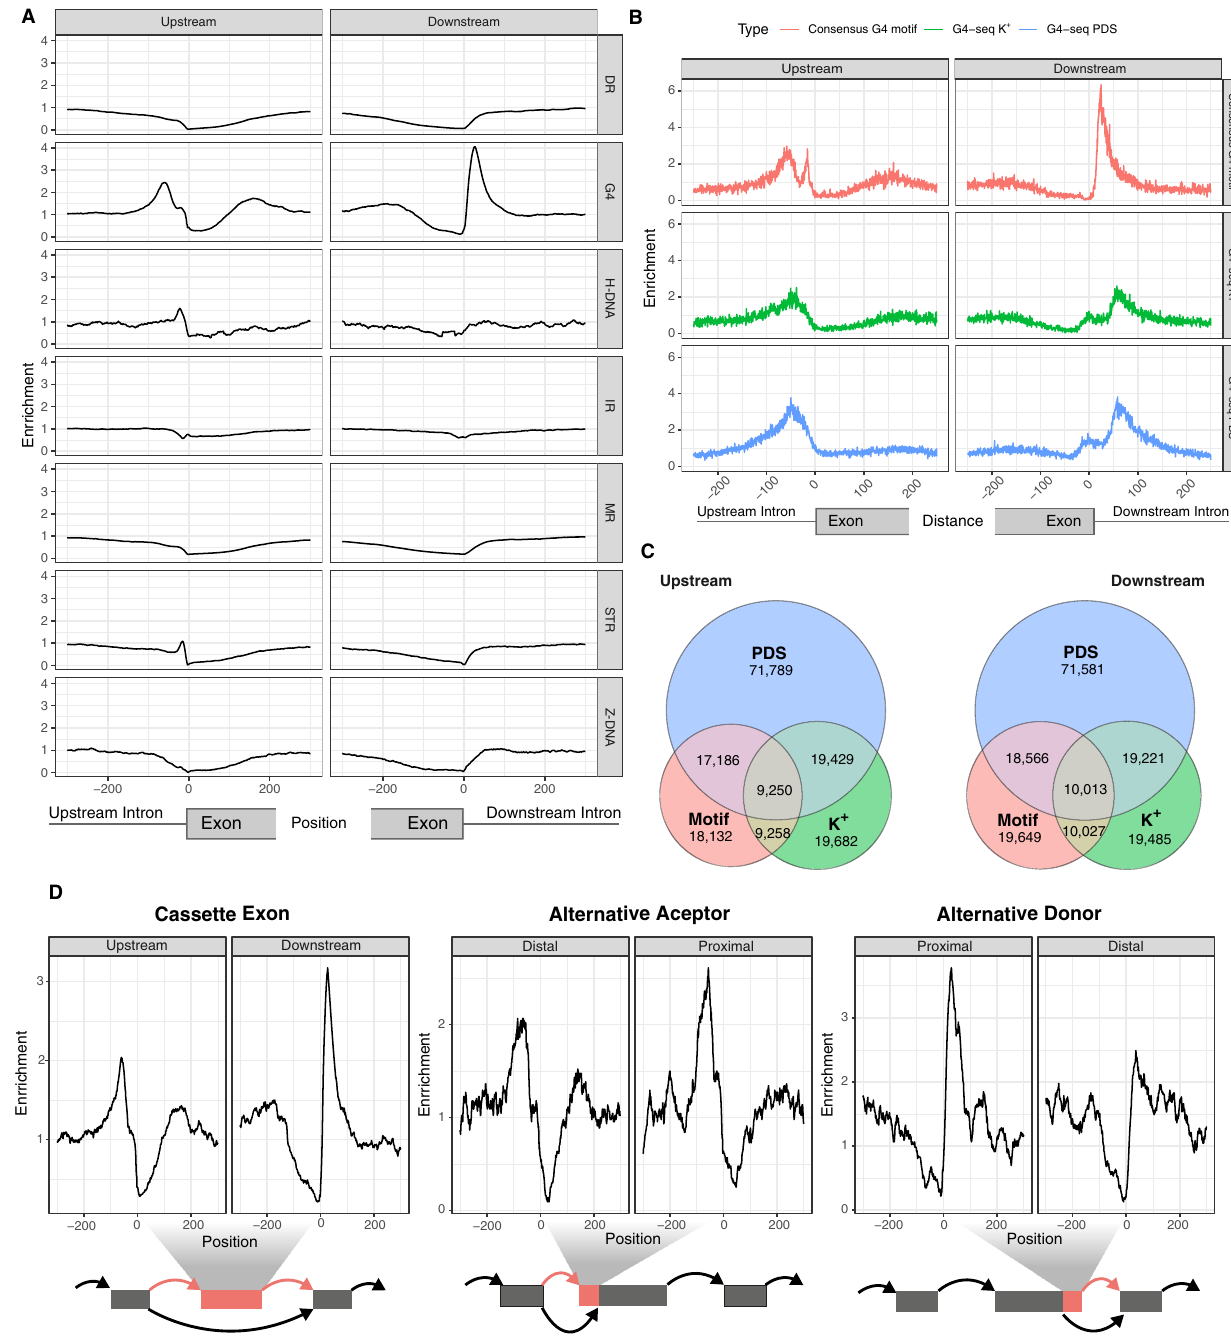
Fig. 1 Non-B DNA motifs at splicing junctions. A Distribution of non-B DNA motifs relative to splice sites. Seven non-B DNA motifs are shown, namely direct repeats (DRs), G-quadruplexes (G4s), H-DNA, inverted repeats (IRs), mirror repeats (MRs), short tandem repeats (STRs) and Z-DNA. B Distance between nearest G4 motif/G4-seq peak and a splice site separately for 3 ′ /5 ′ splice sites. C Venn diagrams for the occurrences of G4s within 100 nt of the 3 ′ ss (upstream) and 5 ′ ss (downstream) using the consensus G4 motif, the K + treatment G4-seq derived DNA G4 peaks and the PDS treatment G4-seq derived DNA G4 peaks 51 and reporting the overlapping G4s between them. D Distribution of G4 motifs relative to cassette exons, alternative acceptor and alternative donor. The orange colour in the schematic represents the alternatively included exonic part, corresponding to each type of alternative splicing